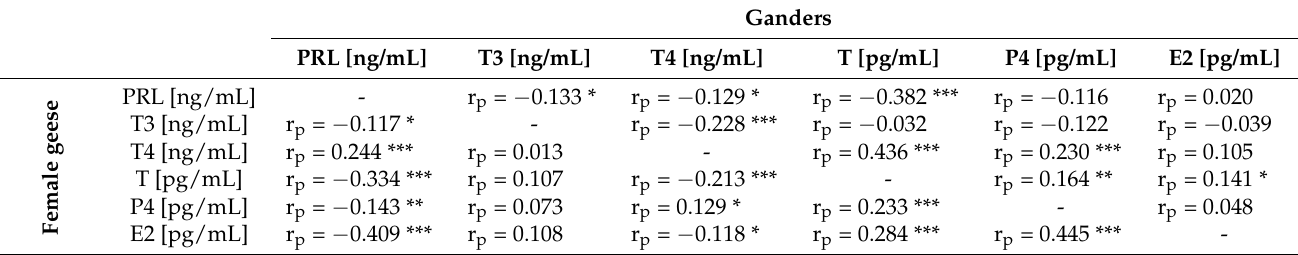
Table 3. Pearson (r p ) phenotypic correlation coefficient for plasma concentration of PRL (prolactin), thyroid hormones (T3–triiodothyronine, T4–thyroxine) and gonadal steroid hormones: T (testosterone), P4 (progesterone), E2 (estradiol) in 2-year-old Zatorska ganders ( n = 10) and female geese ( n = 19) during the annual